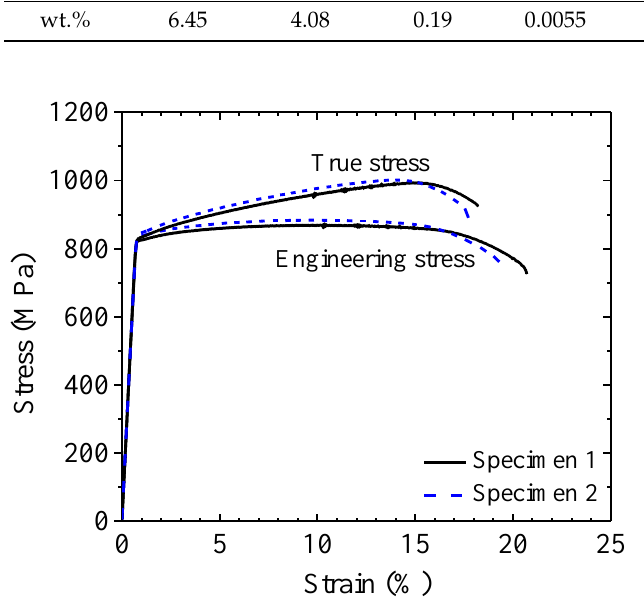
Table 1. Chemical composition (wt.%) of the Ti-6Al-4V ELI alloy. Elements